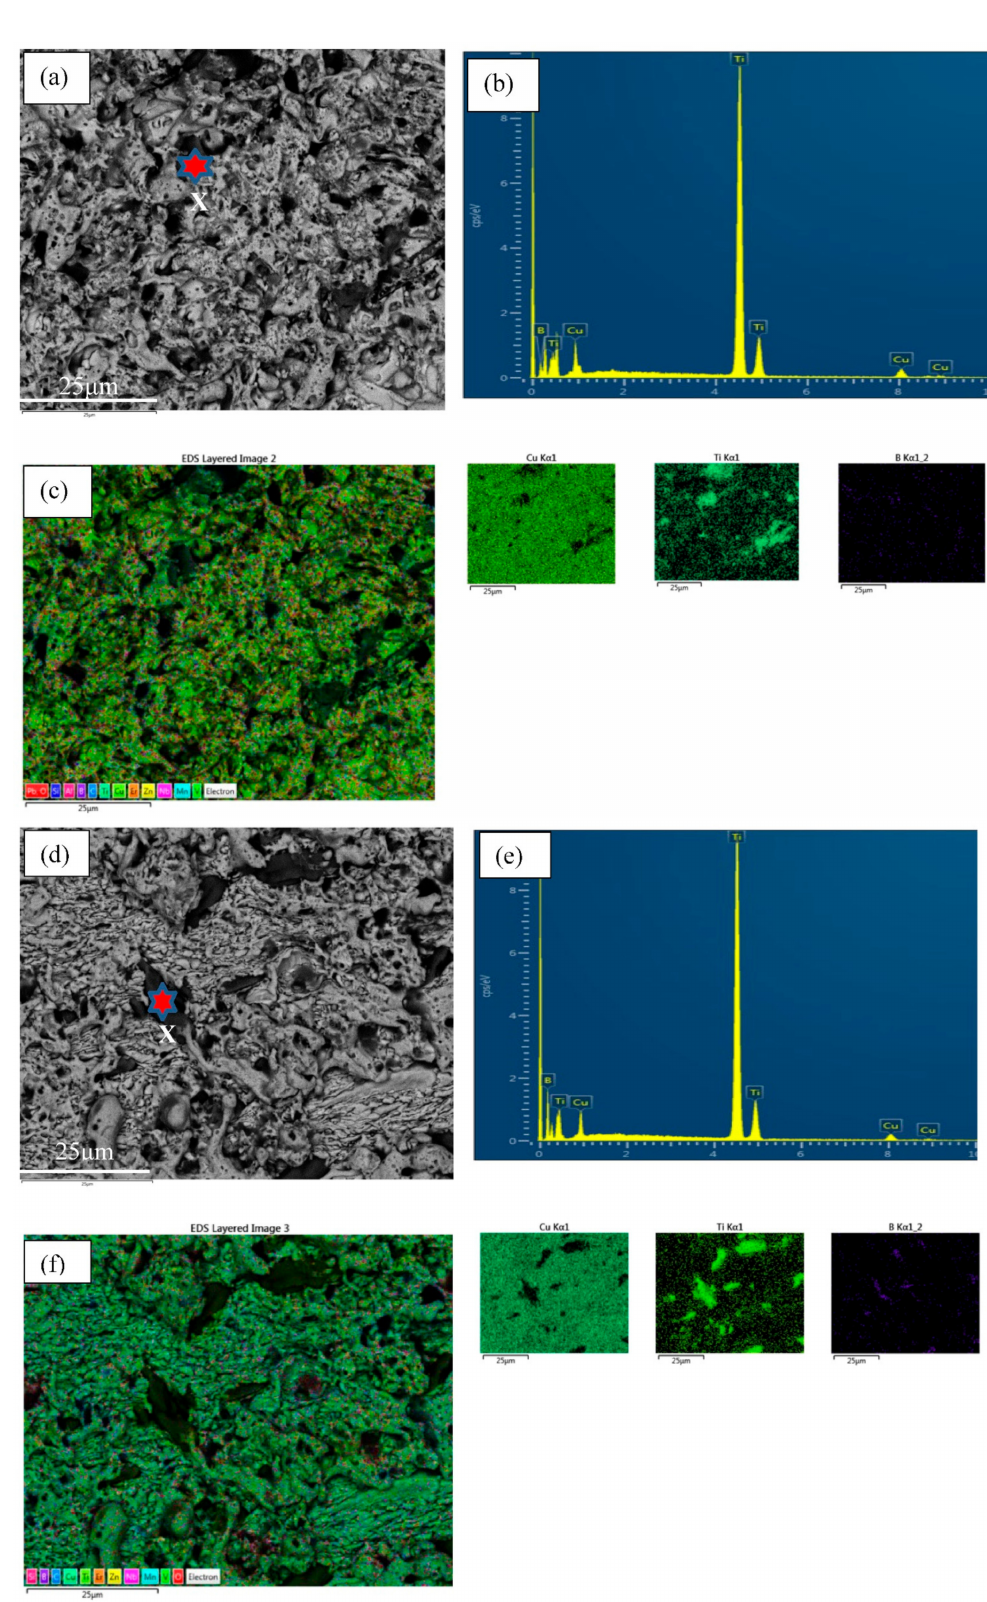
Figure 5. EDX with mapping taken on the red star position of two types of alloy composites ( a – c ) for Cu-2B-4Ti and ( d – f ) for